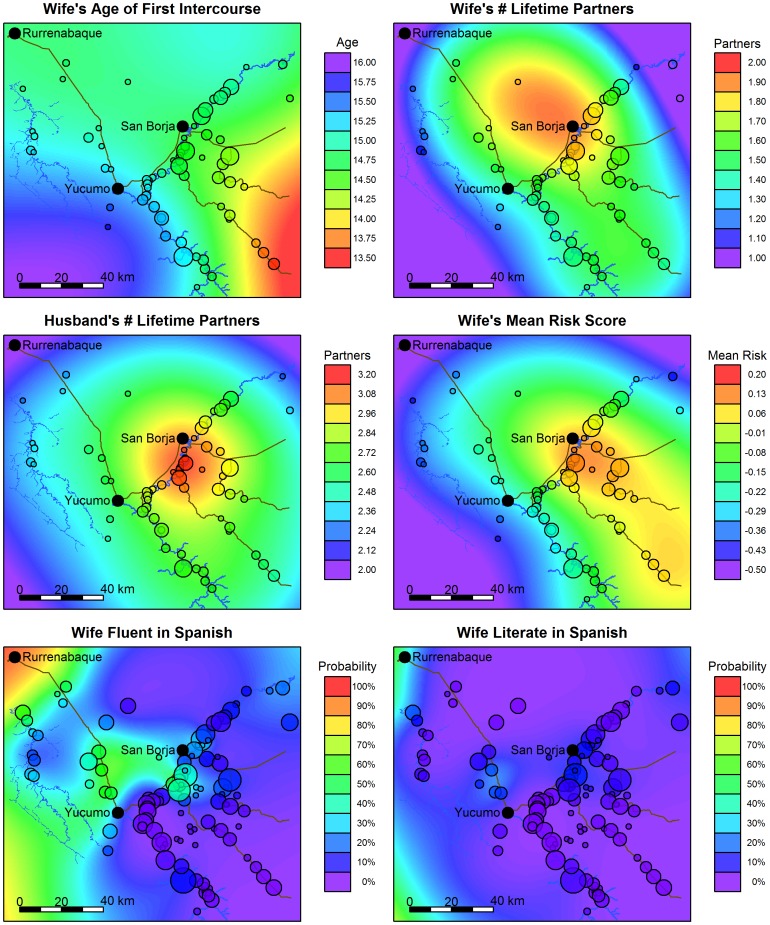
Geographical distribution of risk factors for GM.Distribution of wife’s age at first intercourse and number of lifetime partners for both spouses are based on the GM sample and weighted to adjust for sample bias (see text). To calculate mean risk, wife’s age at first intercourse and number of lifetime partners for both spouses were converted to z-scores and averaged, with age at first intercourse reverse coded. Distribution of Spanish fluency and literacy are based on the sample of women that received medical exams. Circles represent location of study villages, and circle size indicates number of women sampled per village. Estimates are derived from generalized additive models controlling for age. Regions between villages are simulated by the model. Refer to Supplementary Material for geographical distribution without sample weights (figure S3).